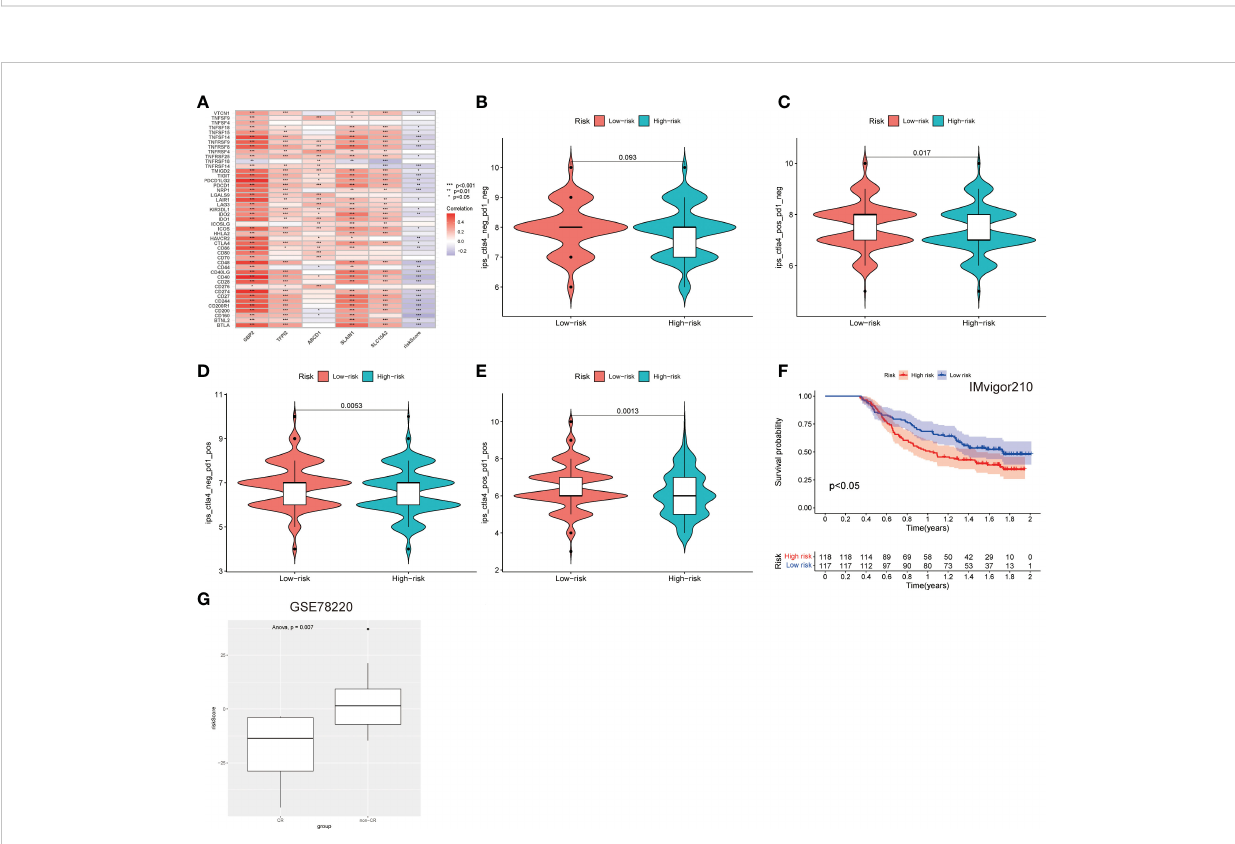
FIGURE 7 The predictive value of the immunotherapy ef fi cacy of the LNPRS in the 3 independent cohorts. (A) The correlation between immune checkpoints, gene expression, and the LNPRS. (B – E) The IPS and response to blockade with CTLA-4 antibody or/and PD-1 antibody for the TCGA cohort. (F) The survival curves for the Imvigor210 cohort. (G) In the GSE78220 cohort, the differences in the LNPRS of patients with distinct chemotherapy